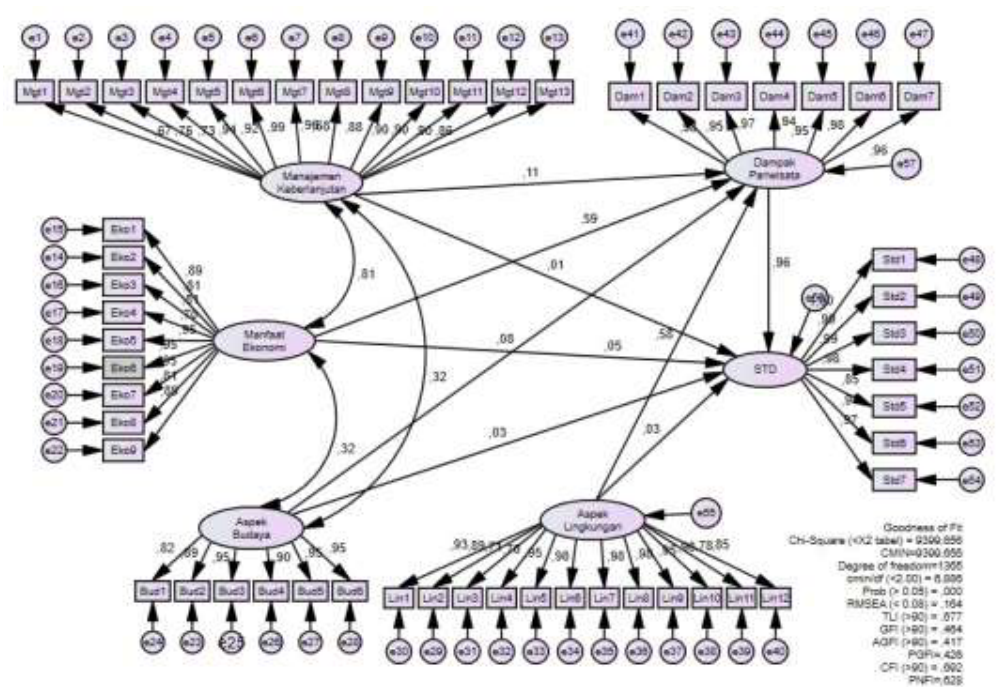
Figure 2. Output Structural Equation Model - Full